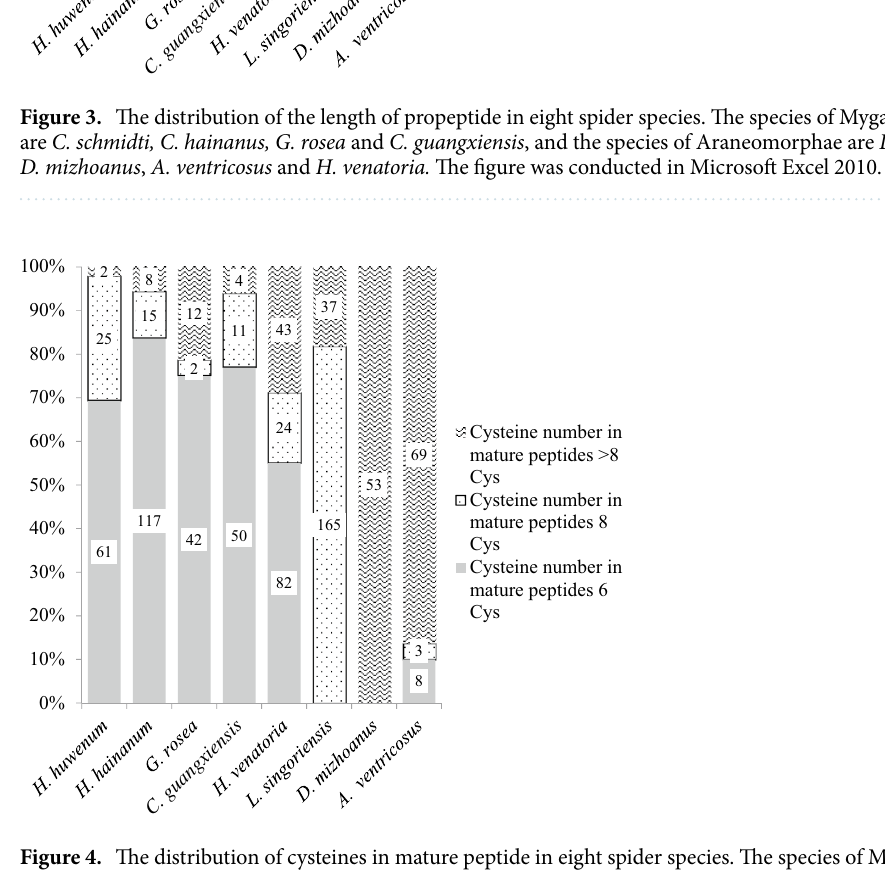
Figure 4. The distribution of cysteines in mature peptide in eight spider species. The species of Mygalomorphae are C. schmidti, C. hainanus, G. rosea and C. guangxiensis , and the species of Araneomorphae are L. singoriensis, D. mizhoanus , A. ventricosus and H. venatoria . The figure was conducted in Microsoft Excel